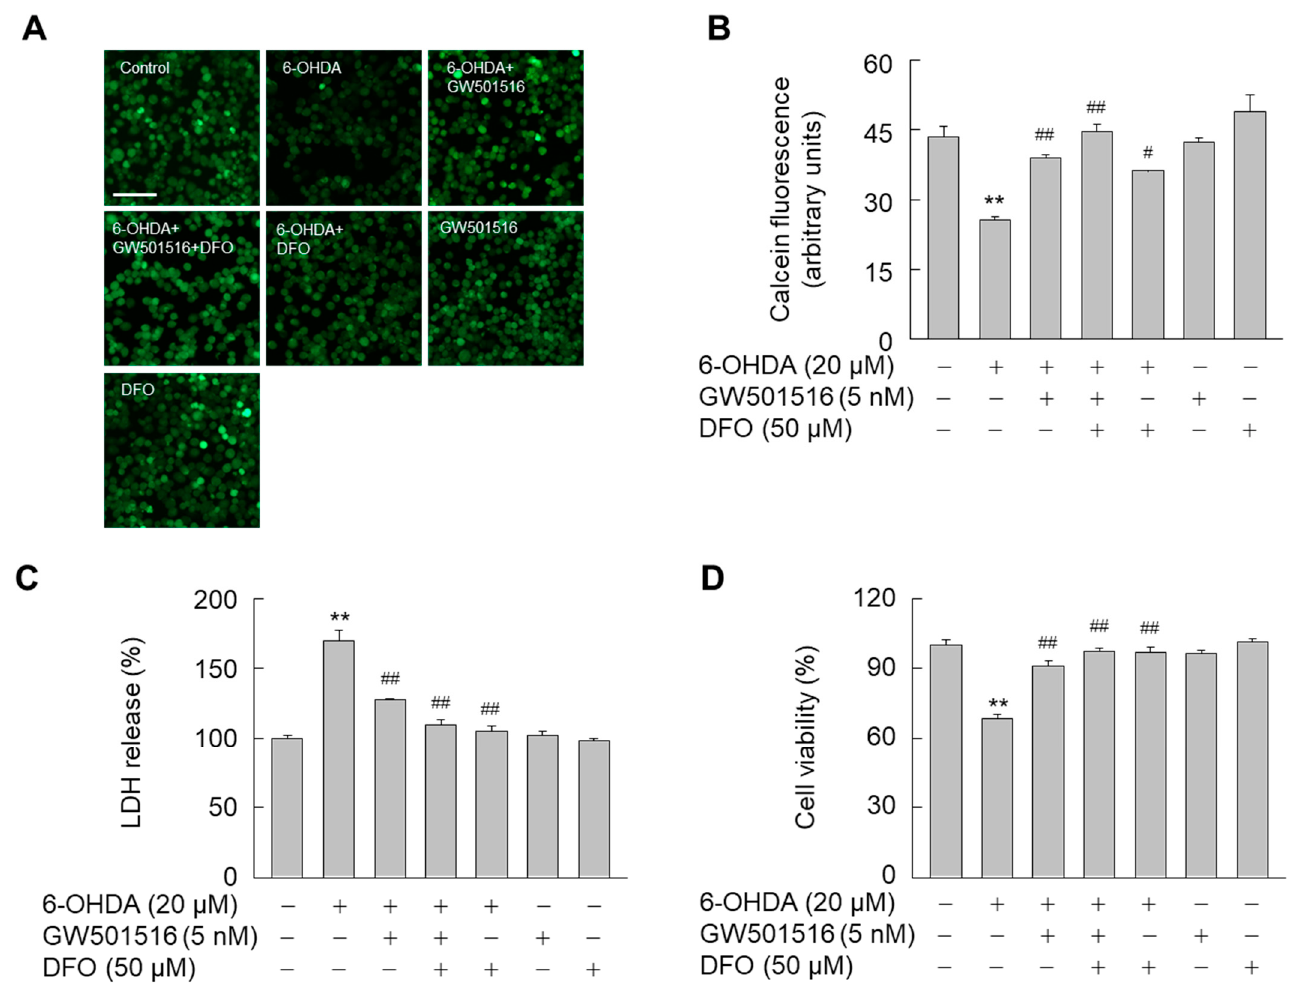
Figure 3. GW501516 activation of PPAR δ suppresses 6-OHDA-triggered accumulation of intracellular iron. ( A , B ) Cells pretreated with vehicle (DMSO) or GW501516 for 8 h were treated with deferoxamine for 1 h and then incubated with or without 6-OHDA for 24 h. Intracellular iron levels were determined by measuring the reduced fluorescence of calcein-AM under fluorescence microscopy ( A ) and calcein fluorescence was quantitated using cells treated with DMSO as control ( B ). ( C , D ) In parallel experiments, 6-OHDA-induced neurotoxicity was evaluated by LDH release ( C ) and MTT assays ( D ). Results are expressed as means ± SE ( n = 3). Scale bar, 100 μ m. ** p < 0.01 relative to untreated group; # p < 0.05, ## p < 0.01 relative to 6-OHDA-treated group.